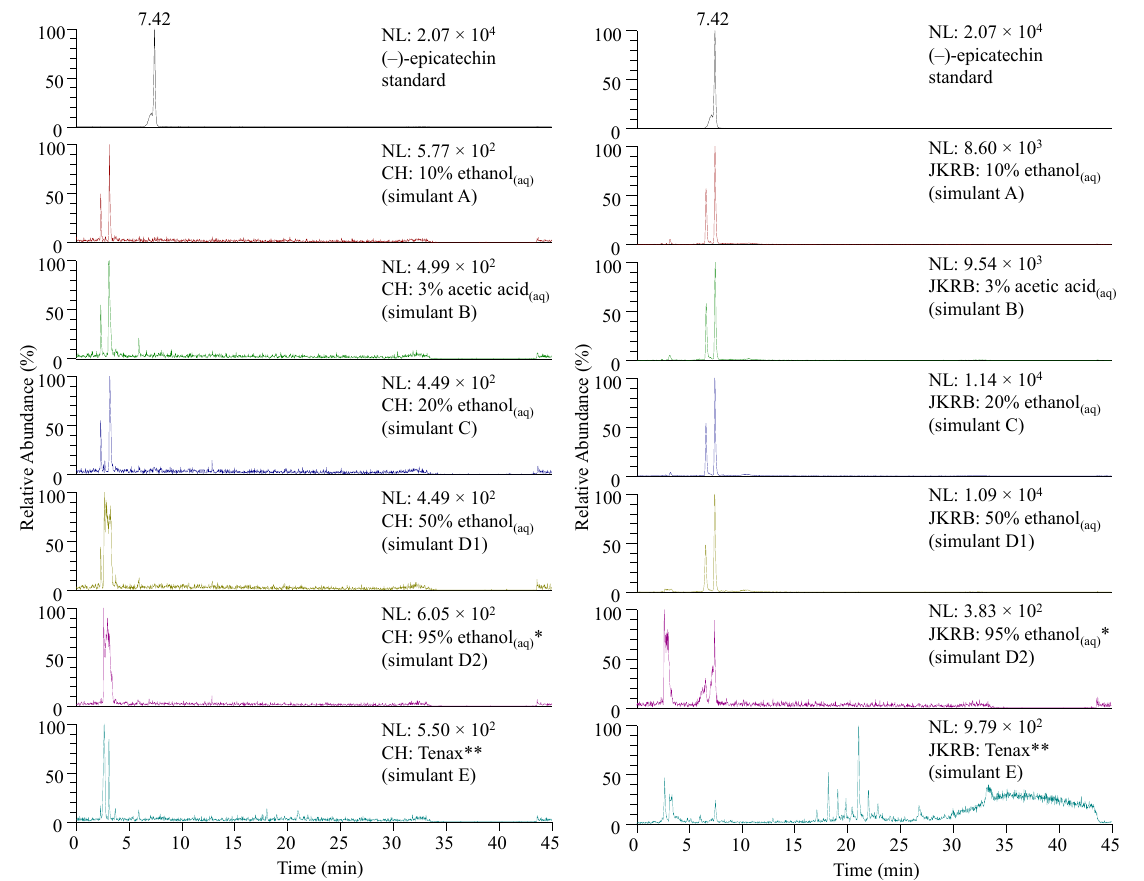
Figure 5. SIM chromatograms of ( − )-epicatechin ( t r at 7.42 min) acquired for stock solutions of liquid food simulants (about 77 mg of biofoil per 20 mL of food simulant after 1 h of contact) analyzed directly, except simulant D (3-fold concentrated) * and extract of simulant E (10-fold concentrated) **. SIM chromatogram of the standard ( − )-epicatechin is shown at the top of each column for comparison. Abbreviations: CH—chitosan biofoil; JKRB—JKRB biofoil.